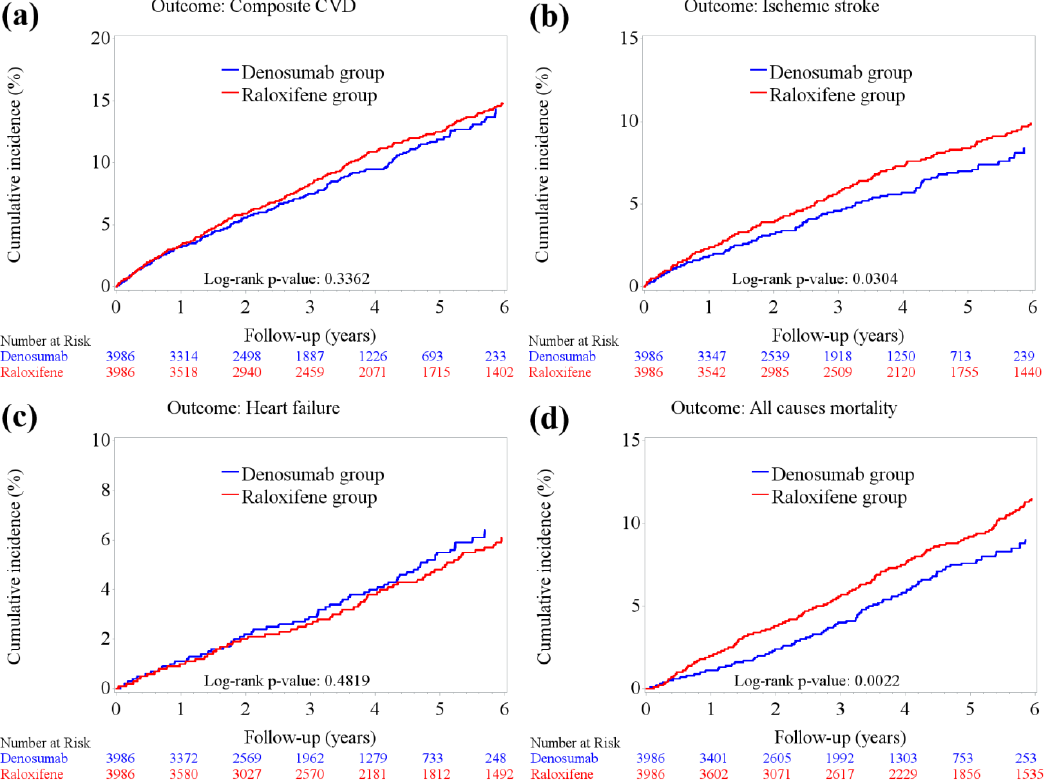
Figure 2. Cumulative incidence of mortality and cardiovascular outcomes in the denosumab and raloxifene groups. ( a ) Composite cardiovascular (CVD) events (log-rank test, p = 0.3362); ( b ) ischemic stroke (log-rank test, p = 0.0304); ( c ) heart failure (log-rank test, p = 0.4819); and ( d ) all-cause mortality (log-rank test, p = 0.0022).